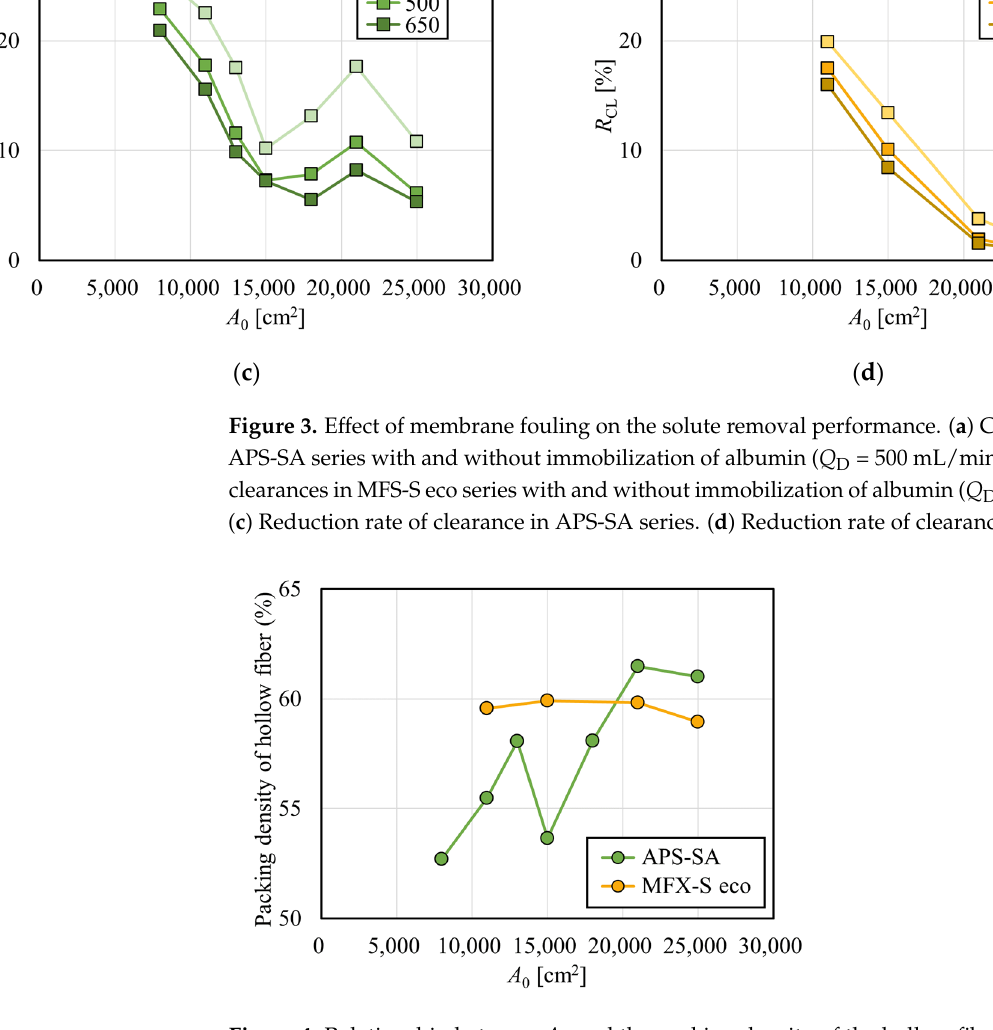
Figure 4. Relationship between A 0 and the packing density of the hollow fiber (PDF).